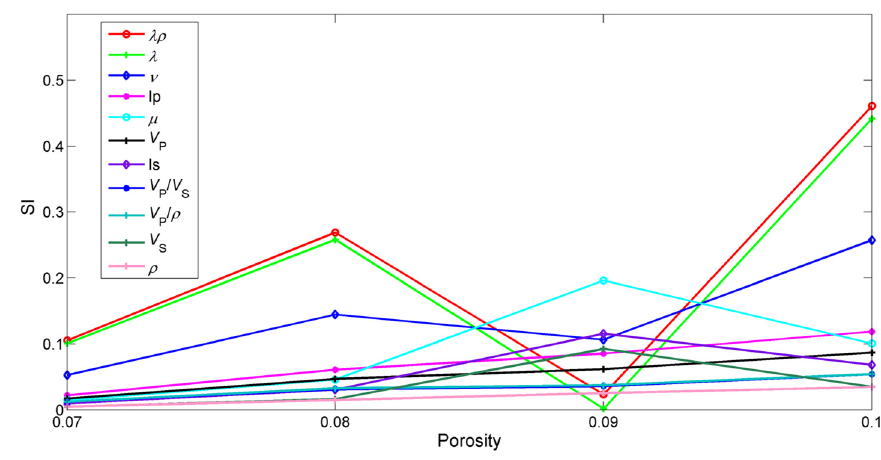
Figure 11. Sensitivity indices varying with the total porosity, based on data from Well P.